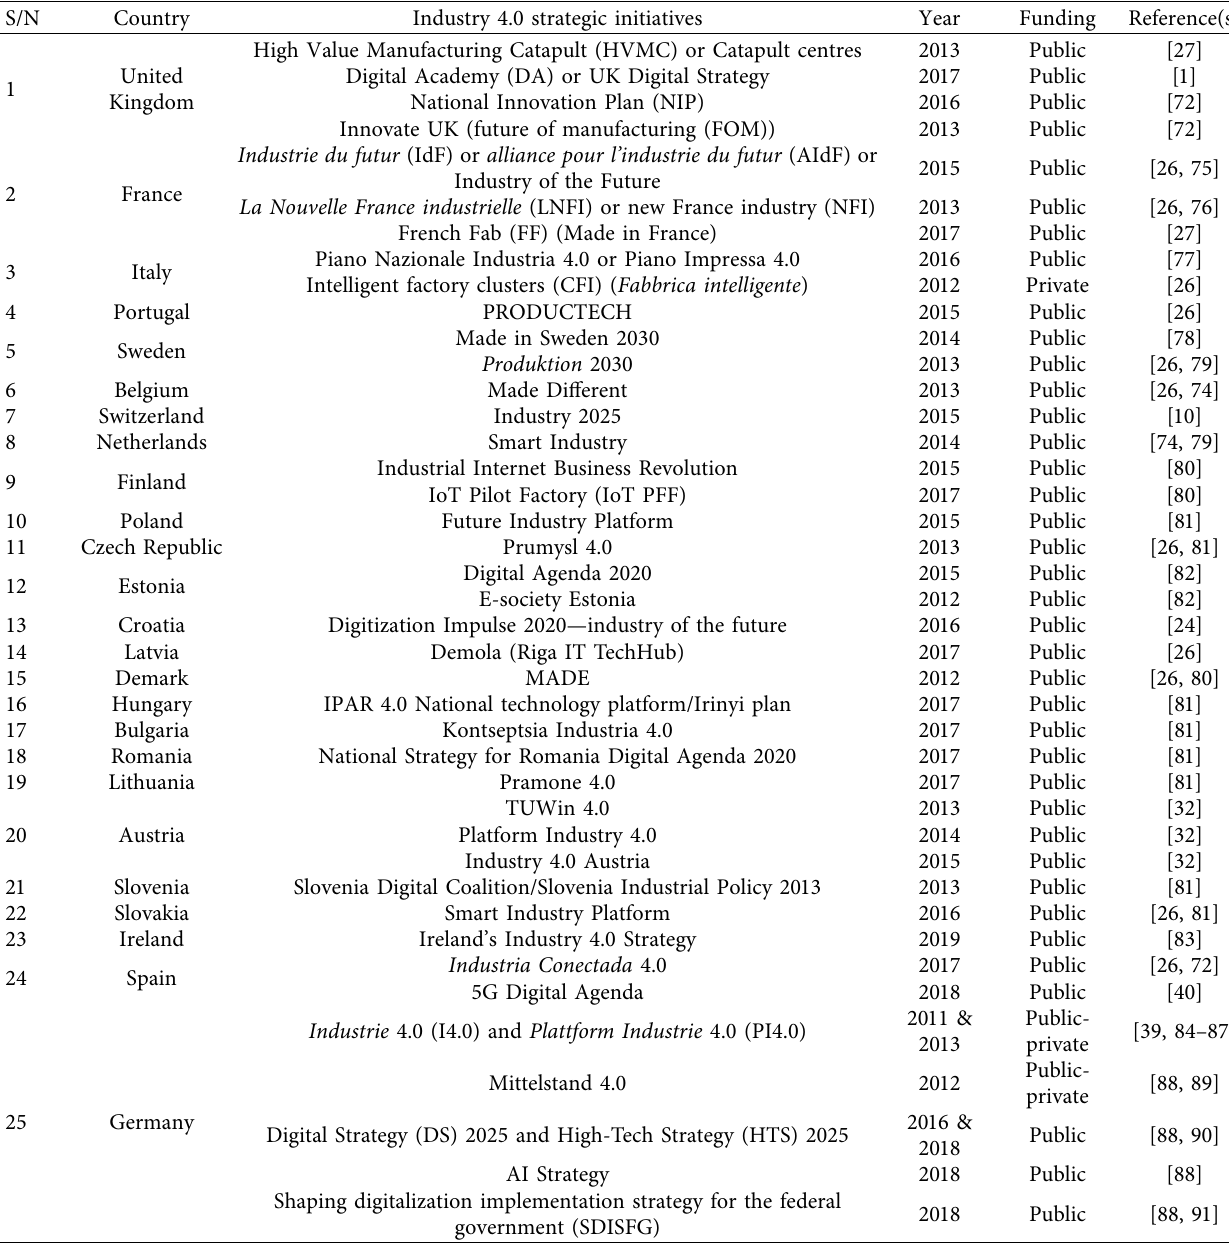
Table 3: Industry 4.0 initiatives launched in